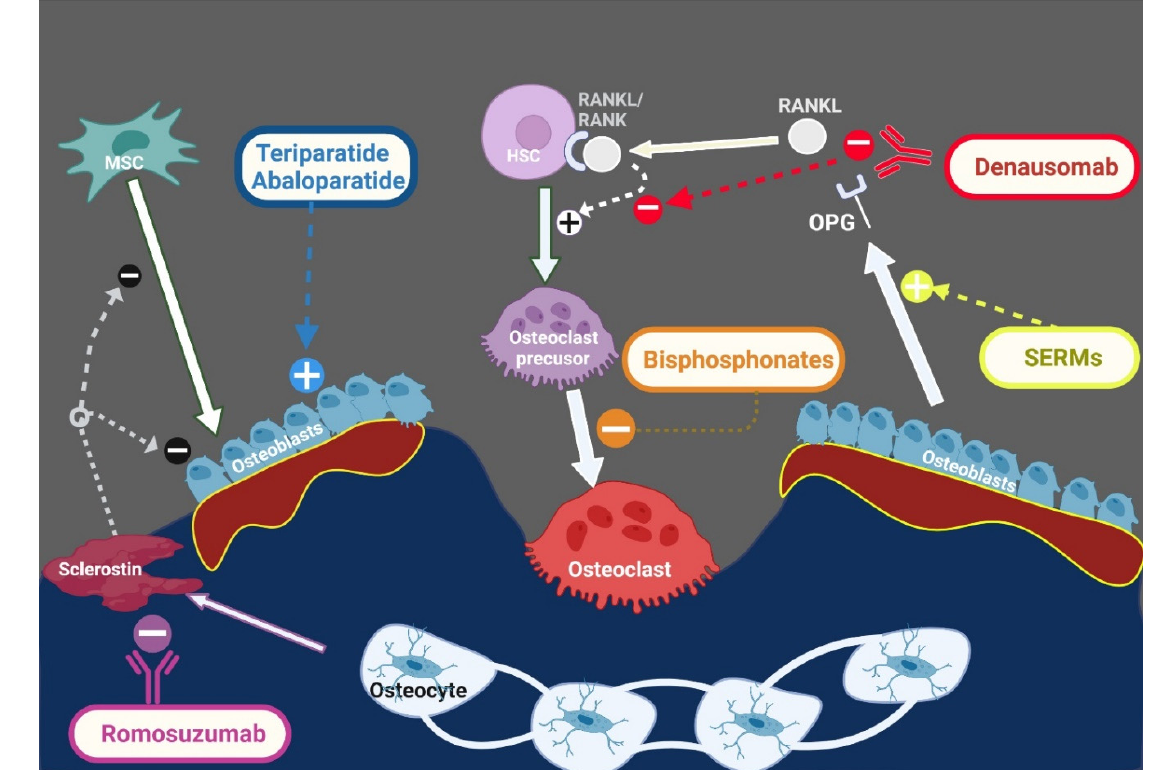
Figure 3. Approach for prevention and management of secondary osteoporosis. Correction of the underlying causes of secondary osteoporosis is the cornerstone of prevention and treatment. All patients can benefit from non-pharmacological intervention, DEXA scan and assessment of fracture risk. Anti-osteoporotic medications (antiresorptives and osteoanabolics) can be used in selected cases with high fracture risk. DEXA: dual-energy X-ray absorptiometry, FRAX: fracture-risk algo- rithm, SERM: Selective estrogen receptor modulators.